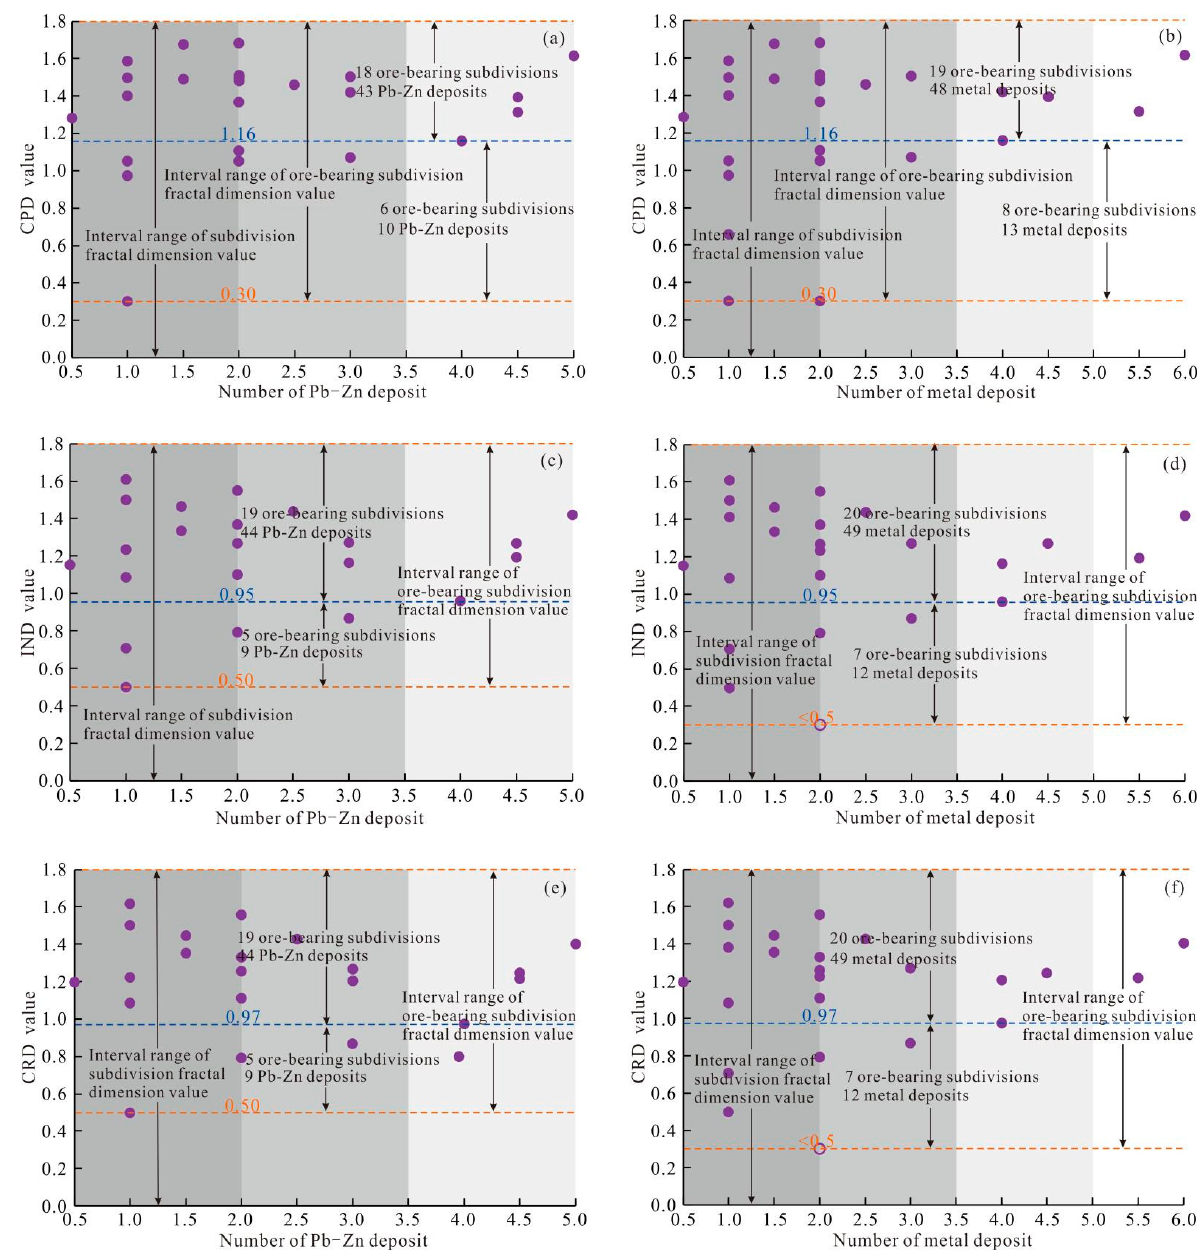
Figure 10. Subdivision projection maps of deposit quantity versus fractal dimension. ( a ) Subdivision projection maps of Pb–Zn deposit quantity versus CPD; ( b ) Subdivision projection maps of all metals deposits quantity versus CPD; ( c ) Subdivision projection maps of Pb–Zn deposit quantity versus IND; ( d ) Subdivision projection maps of all metals deposits quantity versus IND; ( e ) Subdivision projection maps of Pb–Zn deposit quantity versus CRD; and ( f ) Subdivision projection maps of all metals deposits quantity versus CRD.